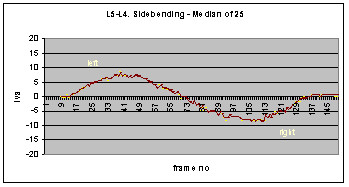
Example from intervertebral motion graph pool. Solid line is median of 25 differences between adjacent vertebral angle series' that met the criteria for inclusion. Scatter plot represents all data points. (acquisition at 5 f/s for 8-bit images).